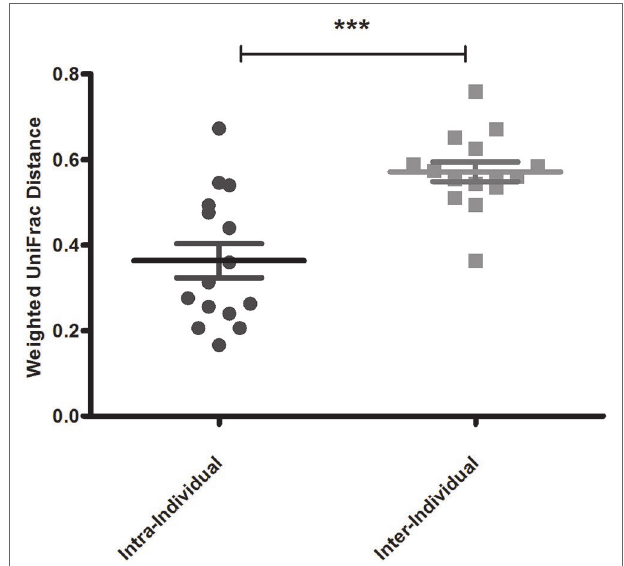
FIGURE 3 | Principal component analysis (PCA) based on OTU level microbiota composition of all samples (PC1 = 26.02%, PC2 = 10.49%). Pre-swab (Pre), Feces (F), Post-swab (Post) are indicated by red triangles; dotted clouds indicate 7 (brown) and 20 days (blue) of age separating age-related microbiota composition irrespective of sample type. The colors denote individual animals.